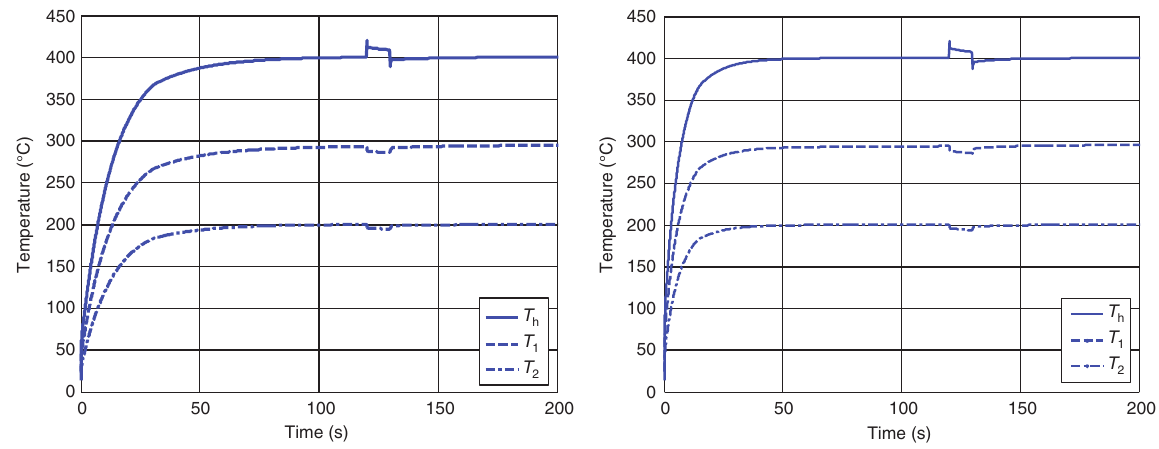
Figure 7 Disturbance rejection performances of the controllers: (A) LQR, (B)